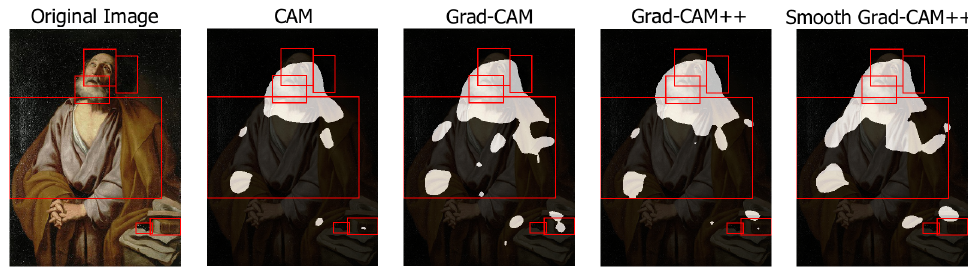
Figure 16. Class activation maps with merged symbols and missed generic